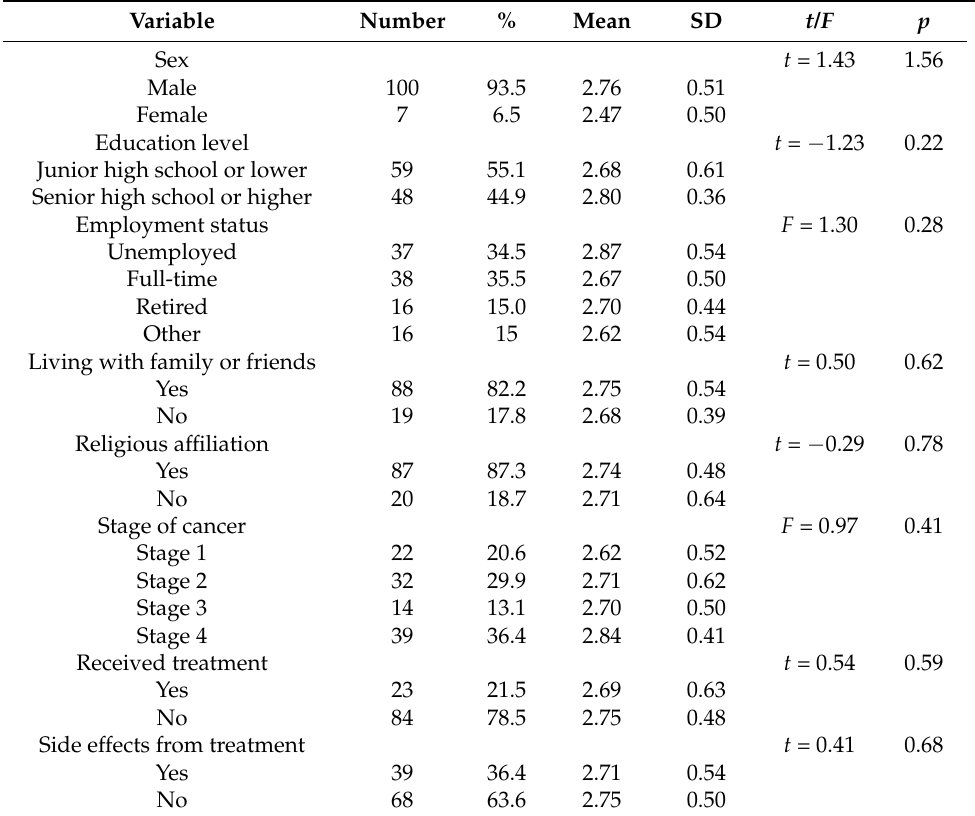
Table 2. Differences in total burden according to patients’ sociodemographic information and medical characteristics ( n =